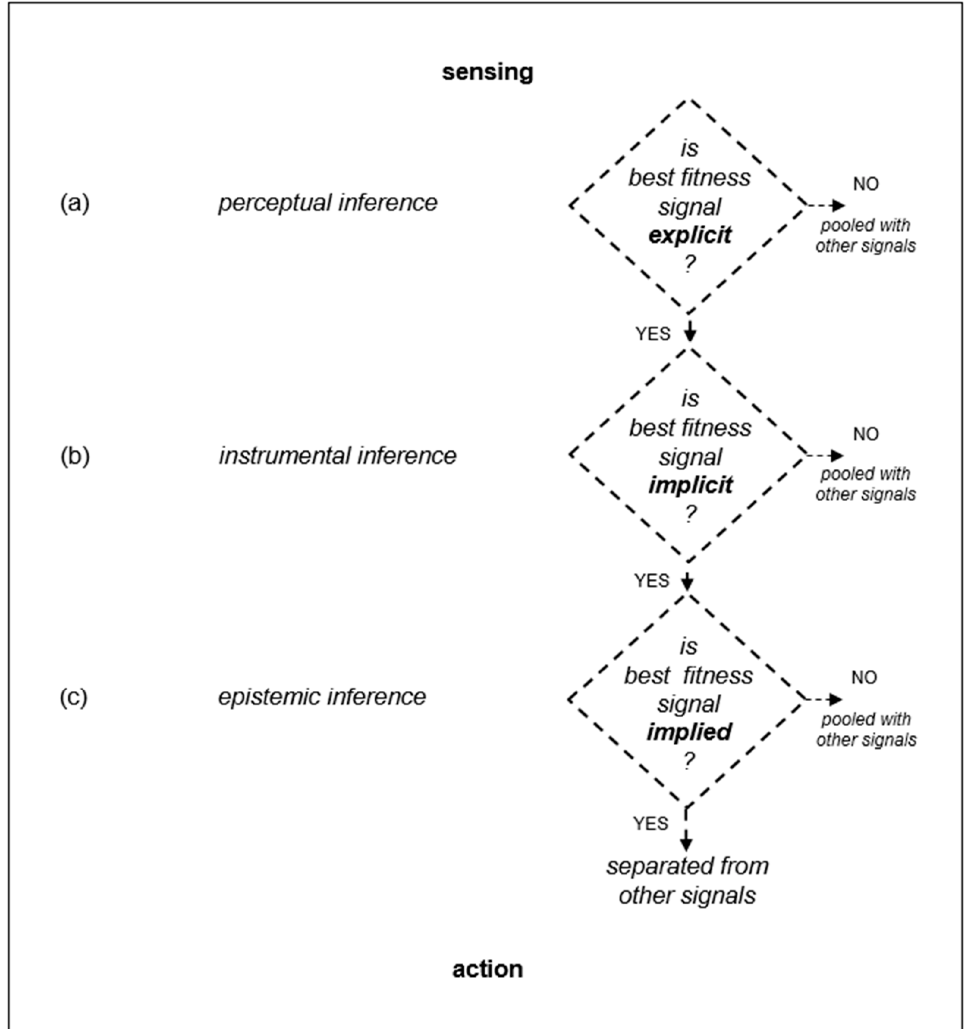
Figure 2. Multi-level inference of signals. ( a ) Perceptual inference of whether or not there is an